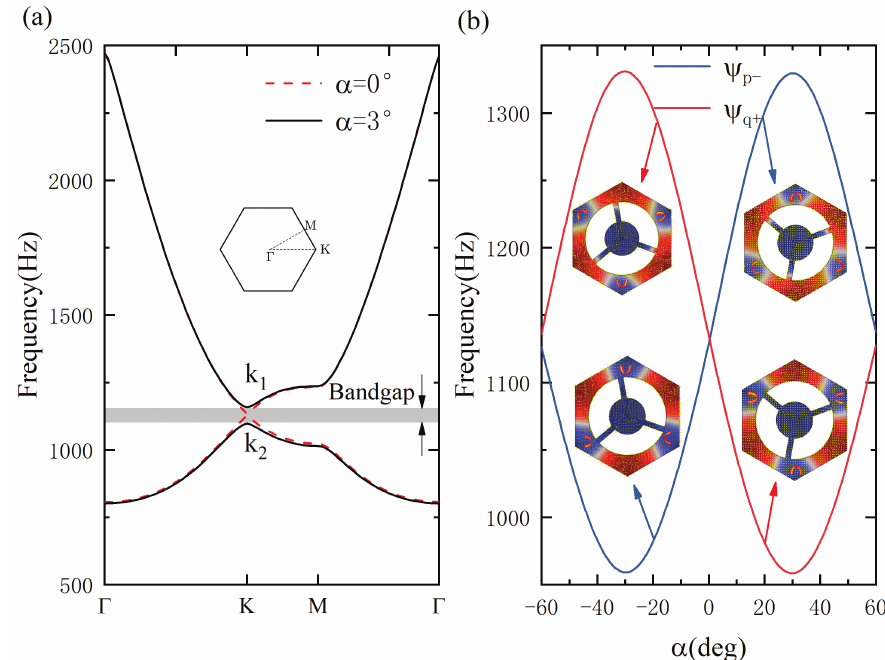
Figure 2. Band structure of the locally resonant metamaterial: ( a ) dispersion relationship of α = 0 and α = ± 3 ◦ ; ( b ) relationship between the design bandgap and the rotational parameter, and vibrational modals and vortex vectors of upper and lower